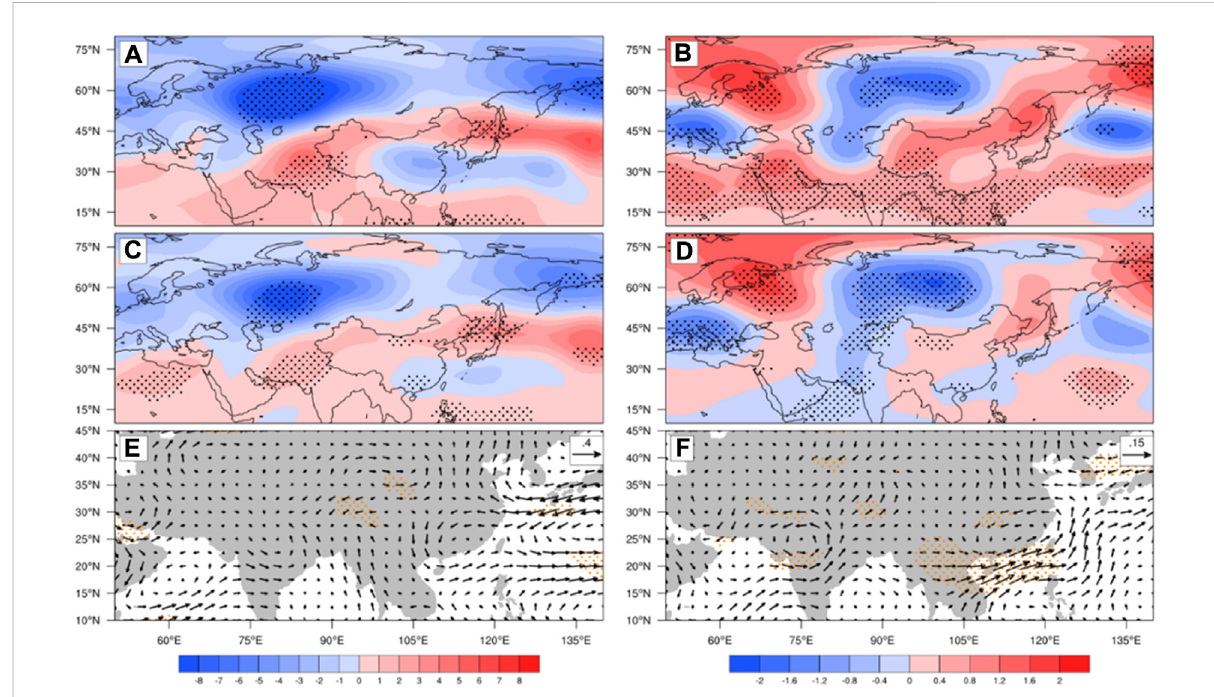
FIGURE 6 Regressions of 30 – 90 days fi ltered 200 hPa (A,B) and 500 hPa (C,D) geopotential height anomalies (unit : gpm) and 850 hPa (E,F) wind (unit : ms − 1 ) onto the time series of SIR, where a, c, e for P1 and b, d, f for P2 (Dotted areas indicate values signi fi cant at/above the 95% con fi dence level by Student ’ s t